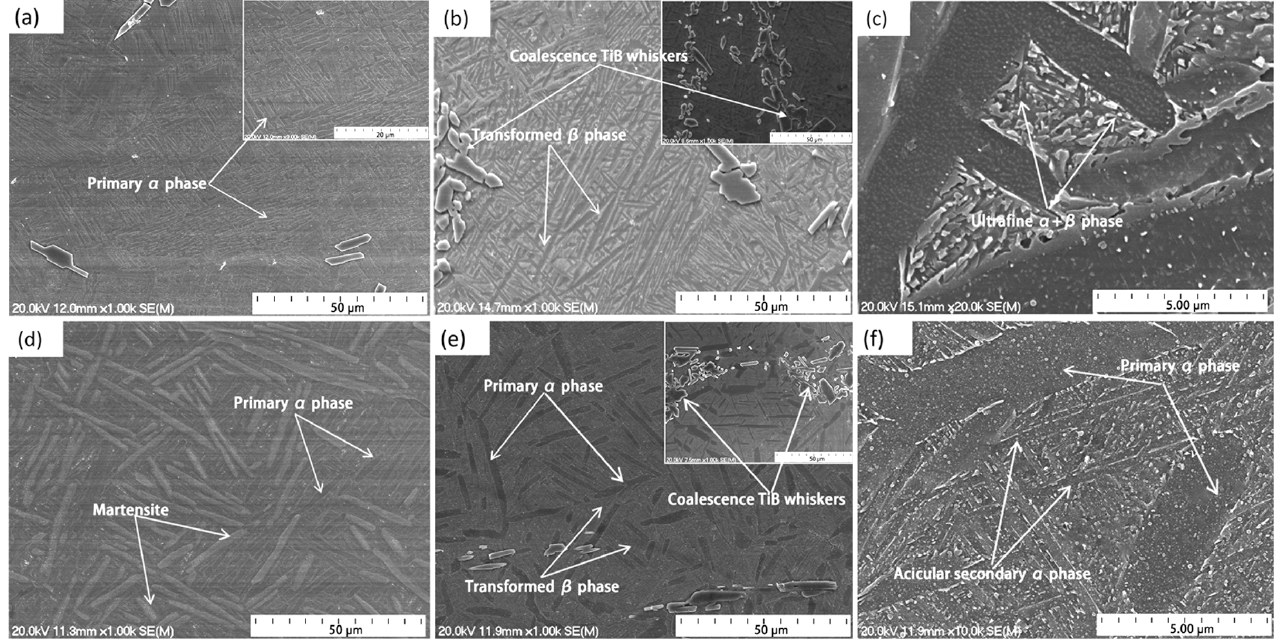
Figure 8. SEM images of Chips-Ti64-3TiB composites after heat treatment: ( a , d ) 855 ℃ /1 h and 955 ℃ /1 h + water quenching; ( b , e ) aged at 550 ℃ /6 h + air cooling; and ( c , f ) high magnification images corresponding to ( b ) and ( e ), respectively.